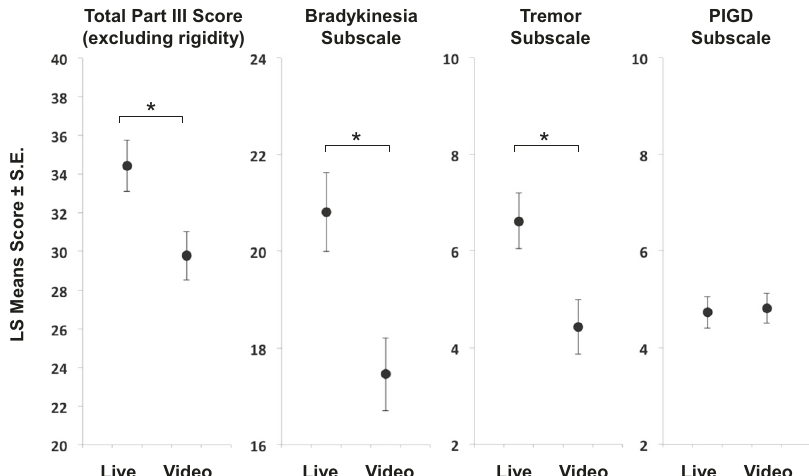
Fig. 3 MDS-UPDRS Part III scores, by subscale. The protocol for studies 2, 3, and 4 each included multiple administrations of part III of the MDS-UPDRS. We pooled scores from live raters and video raters across all participants, all sessions, and all three studies of people with PD ( N = 754 scores) and fi t a mixed effects model with relevant demographic, clinical, and experimental variables. When applying this model to the total score (excluding rigidity items), signi fi cant main effects of rating context (whether the rating had been performed live or by video) were observed where the video ratings underestimated the score. Post hoc least squares means estimates of the total MDS-UPDRS part III score from video raters was signi fi cantly lower than that from live raters by 4.64 ± 0.64 points (left plot, t = 7.3, p < 0.0001) averaged across session condition and gender. The right three plots show the result of fi tting subscale scores for tremor, bradykinesia, and PIGD for the same data set ( N = 754) using the same mixed model. Post hoc least squares means estimates of the bradykinesia and tremor subscales from video raters were signi fi cantly lower than those of live raters (by 3.35 ± 0.45 points, t = 7.5, p < 0.0001, and 2.18 ± 0.23 points ( t = 7.5, p < 0.0001, respectively). Post hoc least squares means estimates for PIGD from video raters, however, were not signi fi cantly different than those from live raters ( − 0.0878 ± 0.13 points, t = − 0.675, p =